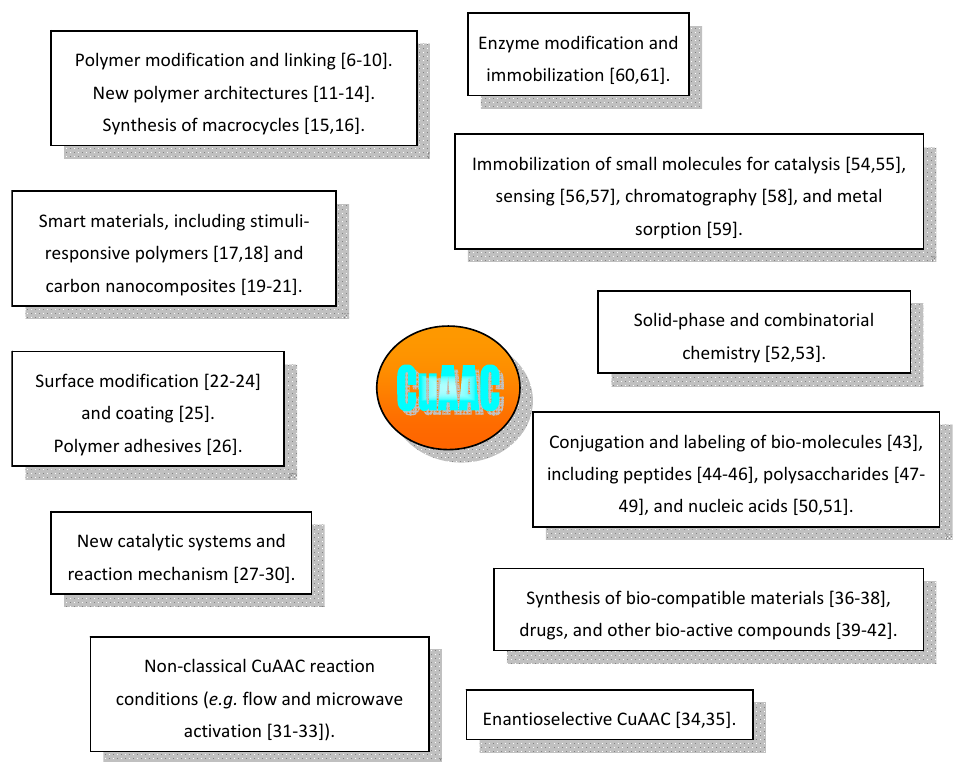
Figure 1. Main publication areas of CuAAC-related papers and selected examples of recent trends.